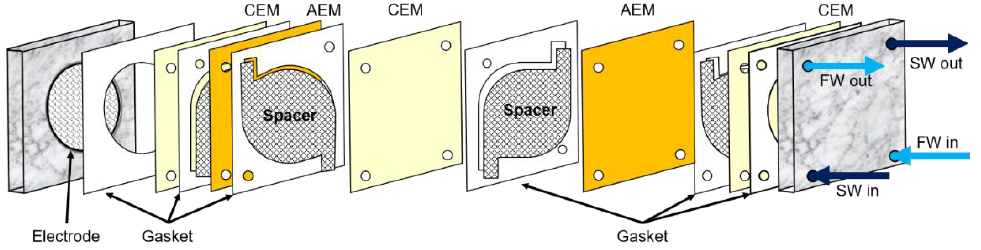
Figure 1. Schematic diagram of a bench-scale RED system. Reprinted with permission from [7]. Two main streams and one electrode stream were supplied to the 20-cell-pair bench- scale RED system. Two synthetic feed streams were seawater with either 0.513 M NaCl